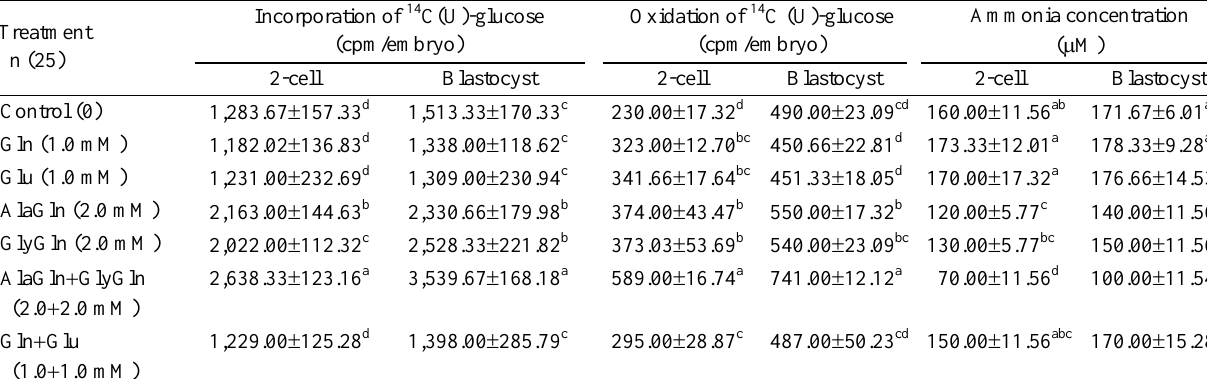
Table 4. The rates of incorporation and oxidation of 14 C(U)-glucose, and the accumulation of ammonia upon treatment with glutamine